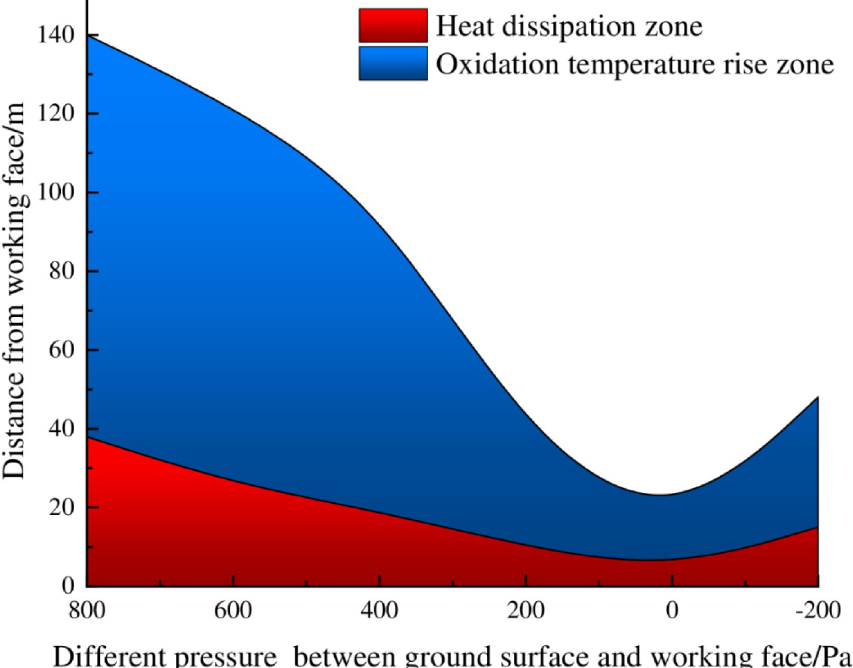
Fig 12. "Three zones" of spontaneous combustion in the goaf under different pressure differences between the mining face and ground